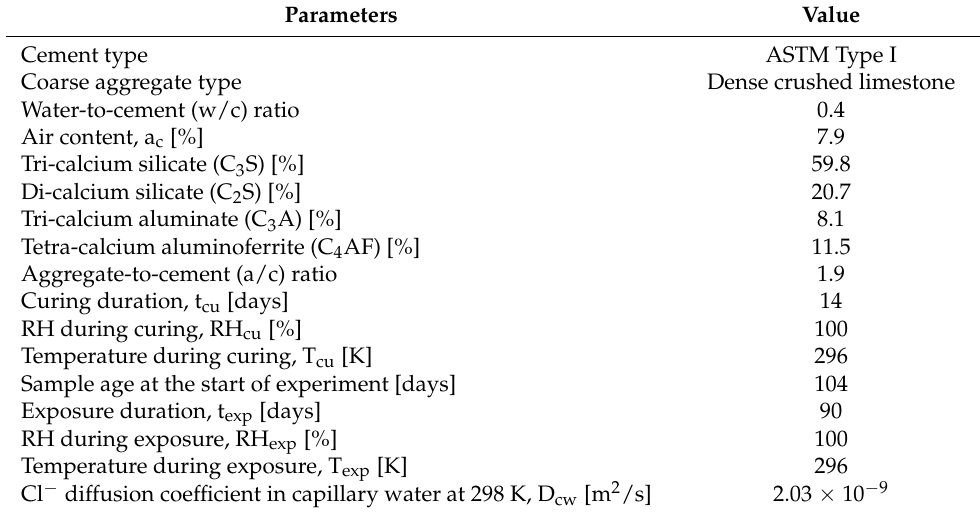
Table 1. List of parameters and their values for verification study.